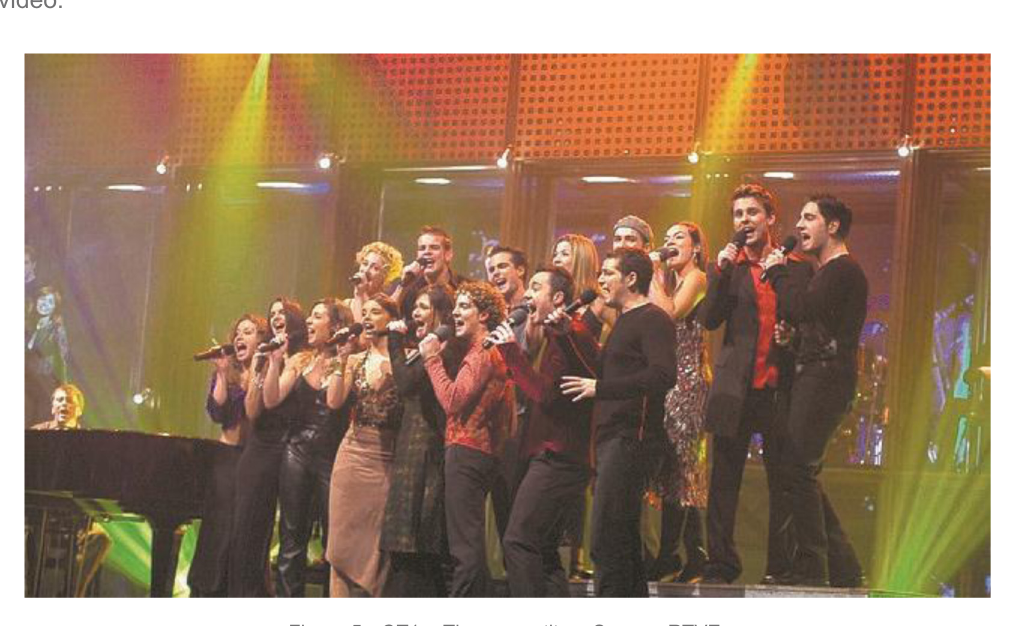
Figure 5. OT1 – The competitors Source: